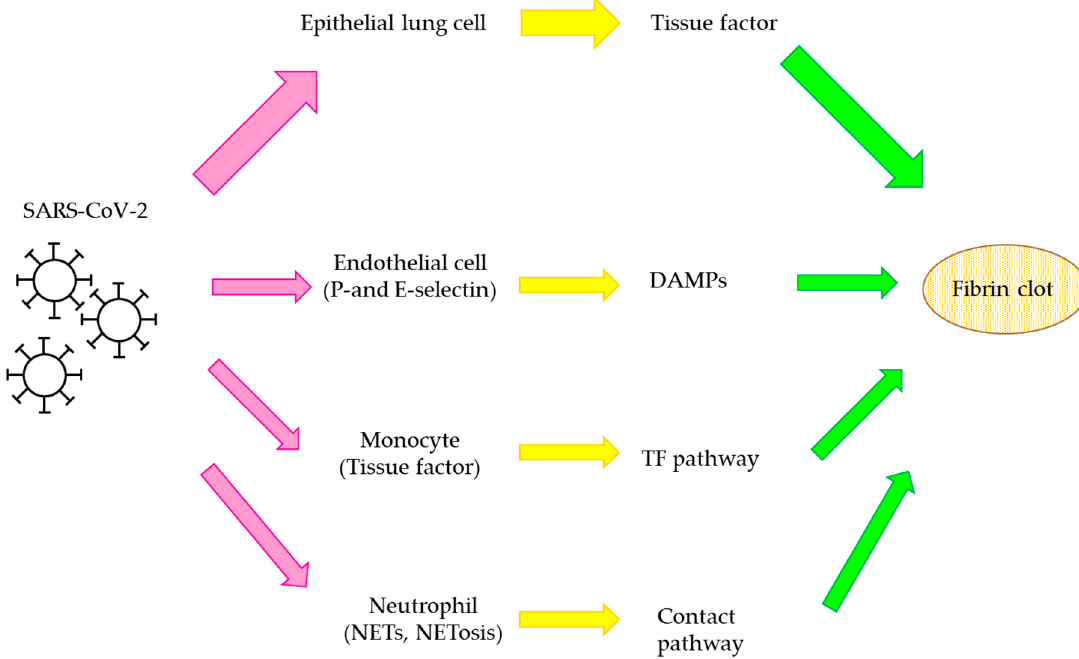
Figure 5. Proposed mechanisms of SARS-CoV-2 associated thrombosis. Several thrombosis mechanisms have been proposed, the important pathogenic effect is the binding and destruction of epithelial lung cells. The phenomenon relates to tissue factor release into blood circulation and activate coagulation pathways at lung sites and extend it throughout the circulatory systems. In addition, infected cells become the trigger to release proinflammatory cytokines and chemokines. The activated endothelial cells upregulate P-selectin and E-selectin leading to recruitment of platelets and leukocytes and complement activation. The infection and recruitment are related to the release of danger-associated molecular patterns (DAMPs). Monocytes activated through complement activation, express tissue factor, and activate coagulation cascades. Neutrophils release NETs which activate the contact pathway directly. Thrombin is generated through these pathways, fibrinogen is converted to fibrin, and the activation of coagulation cascade is related to SARS-CoV-2 associated thrombosis. The reaction of (i) affects to cells, (ii) protein expression, and (iii) the mechanisms of fibrin clot generation were shown as red, yellow and green arrows, respectively.